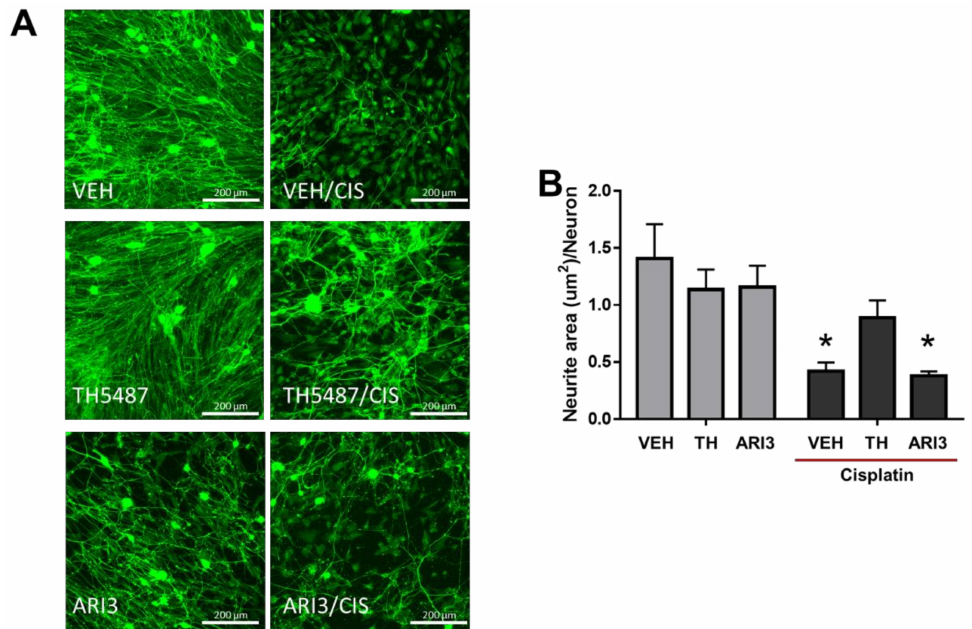
Figure 5. Effects of cisplatin and base excision repair inhibitors on neurite outgrowth. ( A ) Represen- tative immunostaining for PGP9.5 (green) in sensory neuron cultures. The original magnification was × 20. Scale bar represents 200 µ m. ( B ) Quantitative analysis of the axonal area of PGP9.5 staining, acquired using Cytation5 software. * p < 0.01 comparing the indicated groups to the Vehicle-treated control, two-way ANOVA with Tukey’s